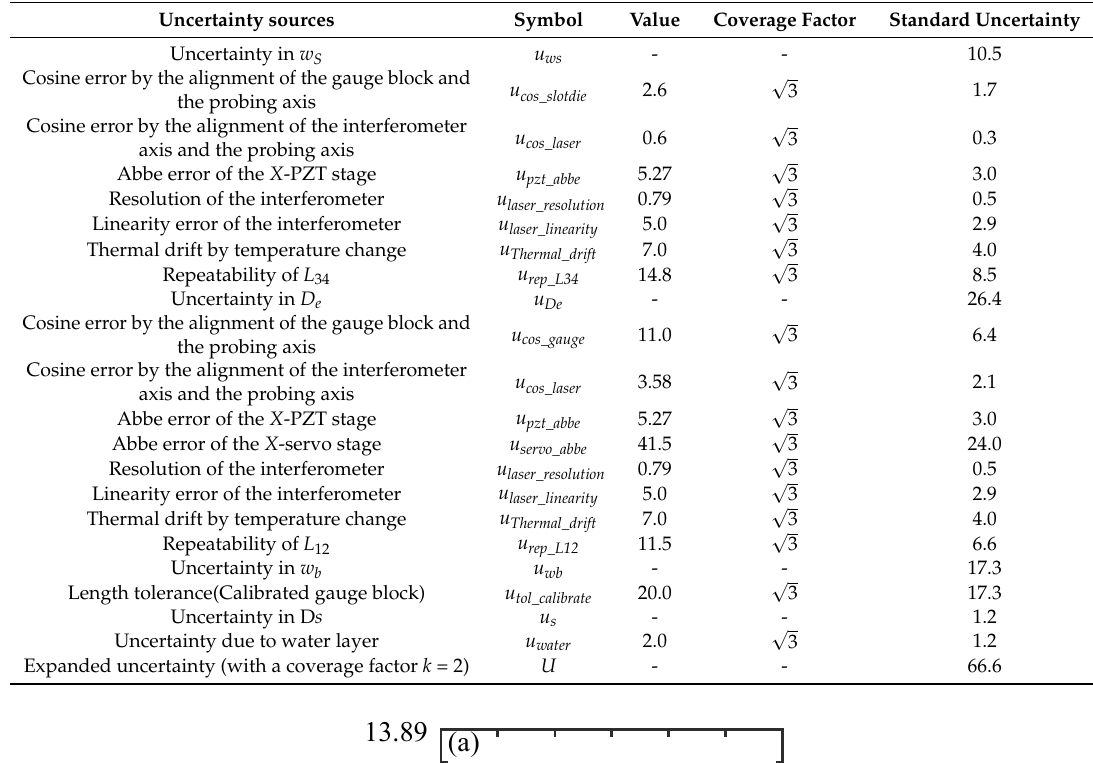
Table 3. Uncertainty budget (unit: nm).